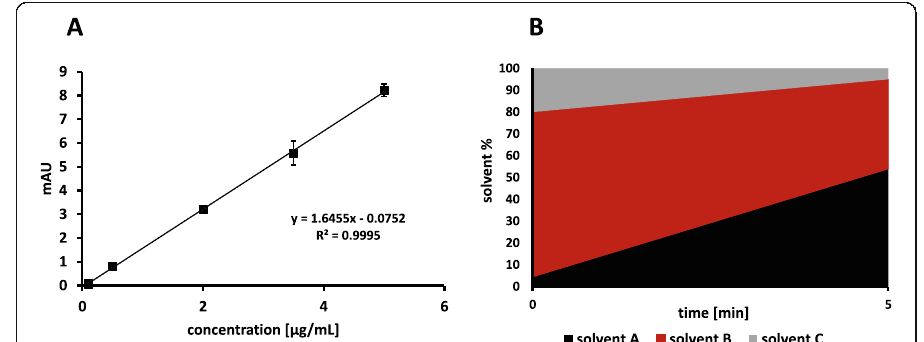
Fig. 4 a Calibration curve of metoclopramide in the range of 0.1 – 5 μ g/mL measured at a wavelength